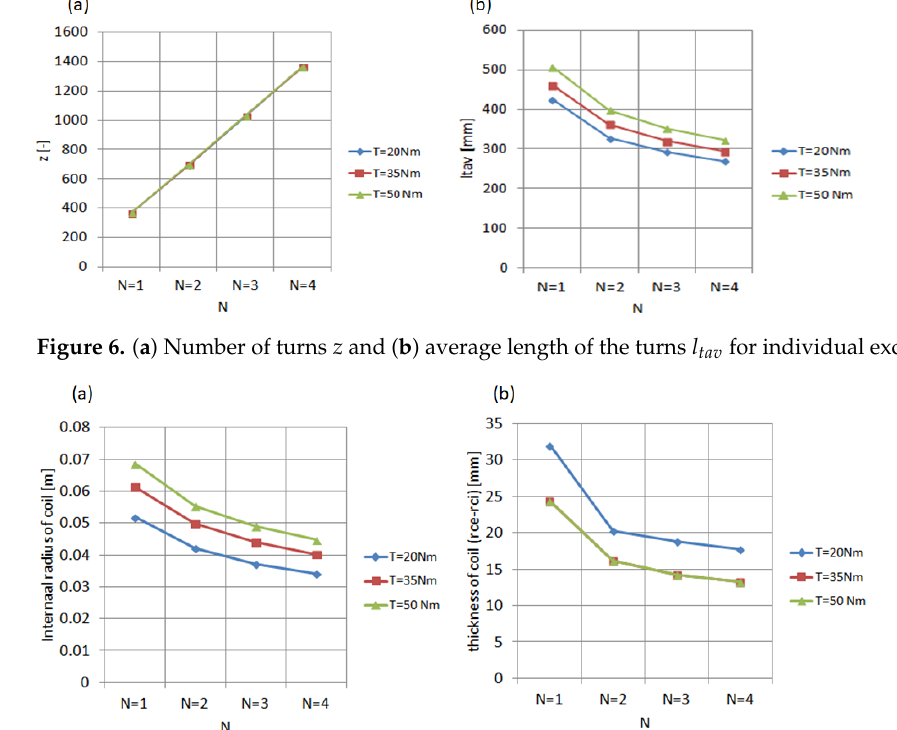
r ci ) vs. number of discs −